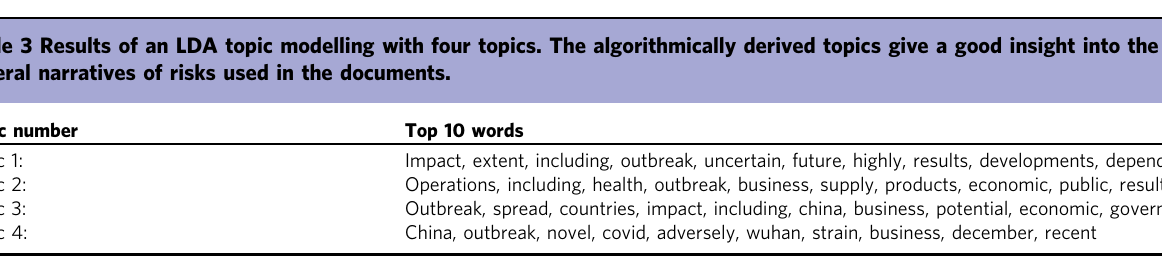
Table 4 Keywords for eight topical domains. We combine the results of the unsupervised methods with domain knowledge from economics to label the eight main topics and specify de fi ning keywords by selecting from the most frequent bi-and trigrams.